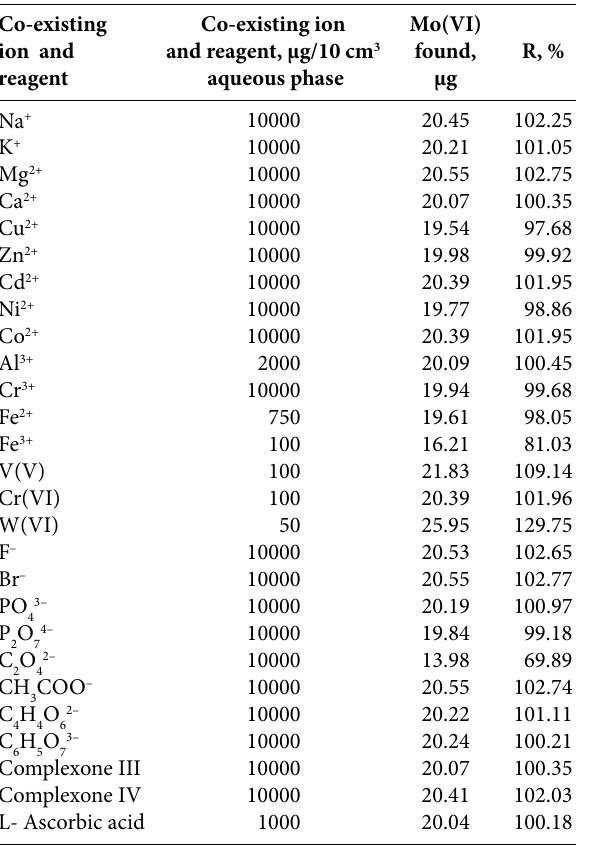
Table 2. Effect of co-existing ions and reagents on the complex for- mation of the ion-associate Mо(VI)–3,5-DNC–INT for extraction in the presence of 20 μg Mo(VI)